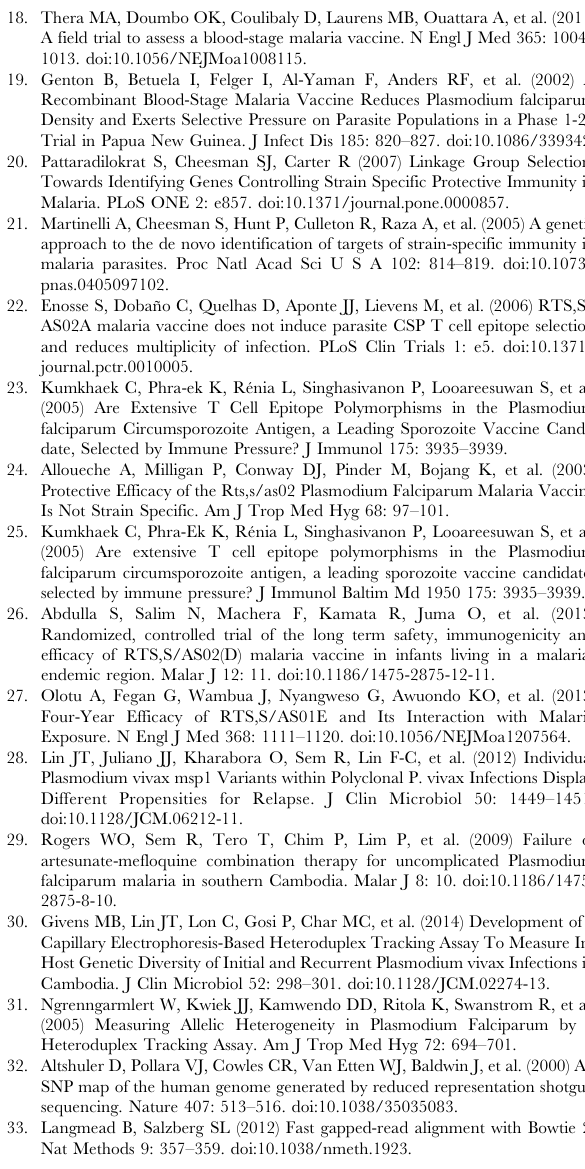
inter-population variability at that site, while values approaching 1 indicate substantial inter-population variability. Coordinates are reported for every third polymorphic site. Table S1 pvmsp-1 and pvcsp sequences included in this study. The PlasmoDB gene identifier is PVX_099980 for pvmsp-1 and PVX_119355 for pvcsp . *Indicates the year the sequences were made available in GenBank. { Indicates study unpublished but sequences available in